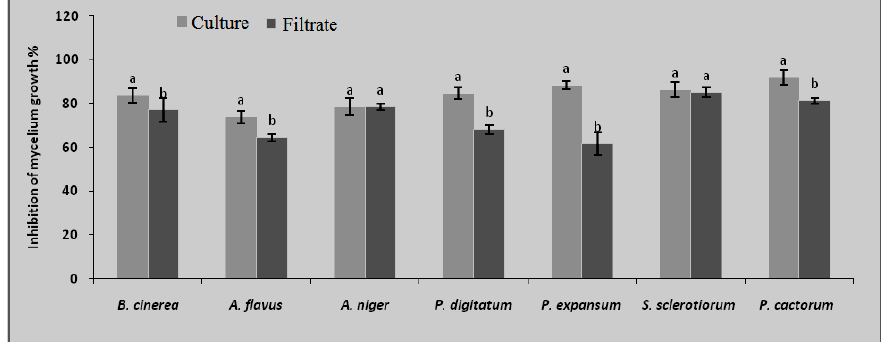
Figure 1. Percentage of growth inhibition (PGI) for cell-free culture filtrate and bacterial culture of Bga ICMP 11096. Bars with different letters indicate mean values significantly different at p < 0.05 according to Tukey B test. Data are expressed as mean of three replicates ±